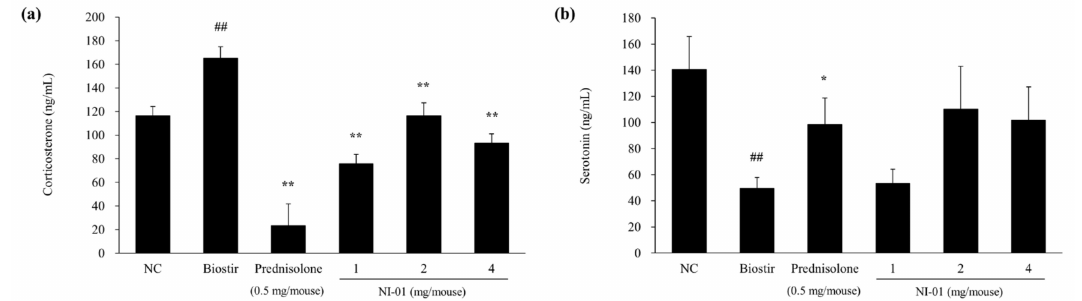
Figure 8. E ff ect of NI-01 on plasma levels of corticosterone ( a ) and serotonin ( b ) in house dust mite treated NC / Nga mice. Corticosterone and serotonin levels were measured by ELISA. Prednisolone was used as a positive control. The data are expressed as the mean ± SEM ( n = 8). ## P < 0.01 compared with the normal control group; * P < 0.05 and ** P < 0.01 compared with the Biostir-AD ® group. NC; normal control, Biostir; Biostir-AD ®